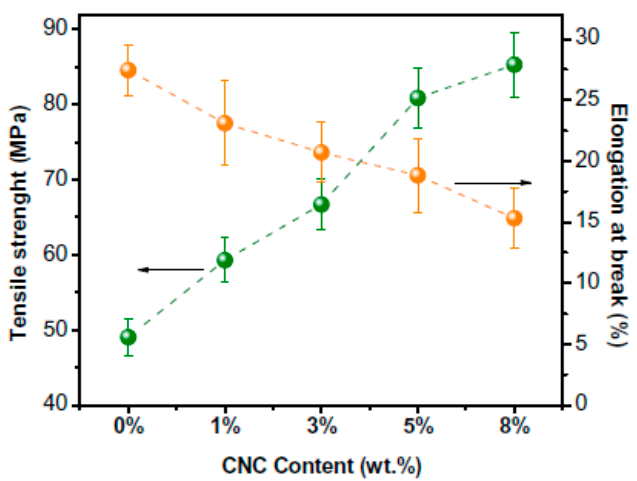
Figure 2. Tensile strength and elongation at break of the kappa–carrageenan (KC) composites with cellulose nanocrystals (CNC, 1 to 8 wt.%) (taken from [9] with permission from Elsevier).